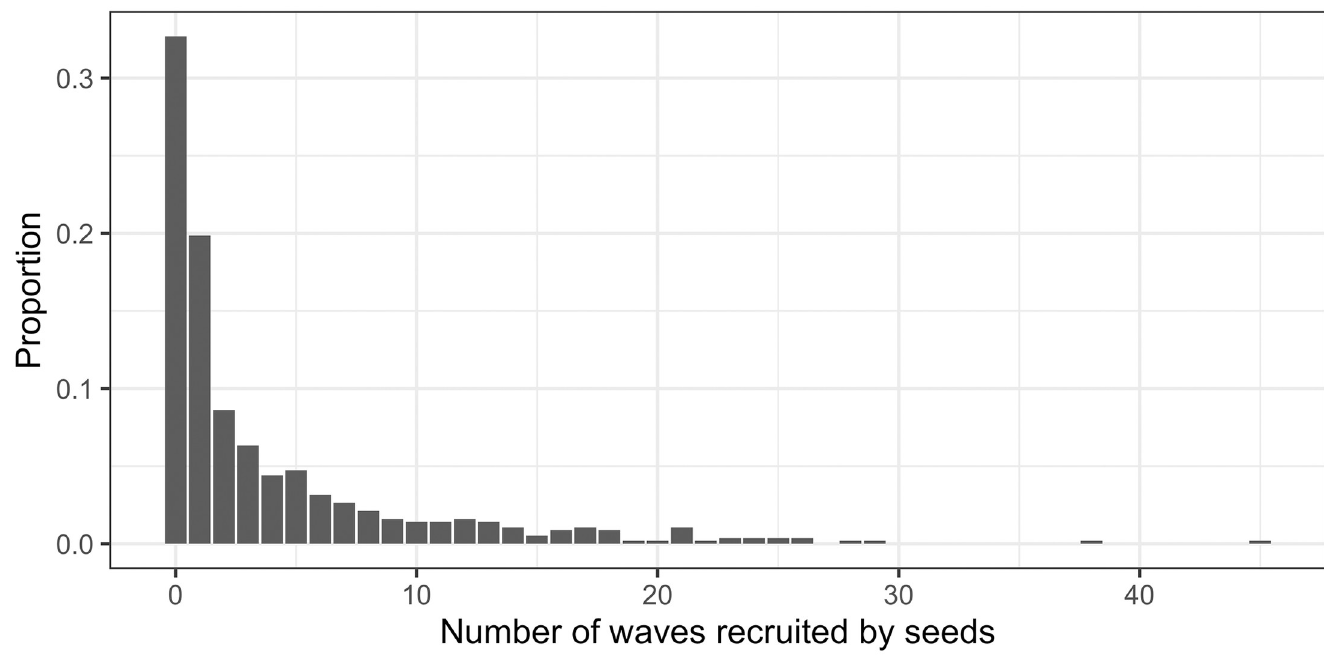
Fig 5. Recruitment waves by seed. Number of waves recruited by seeds (n = 549) across all studies.